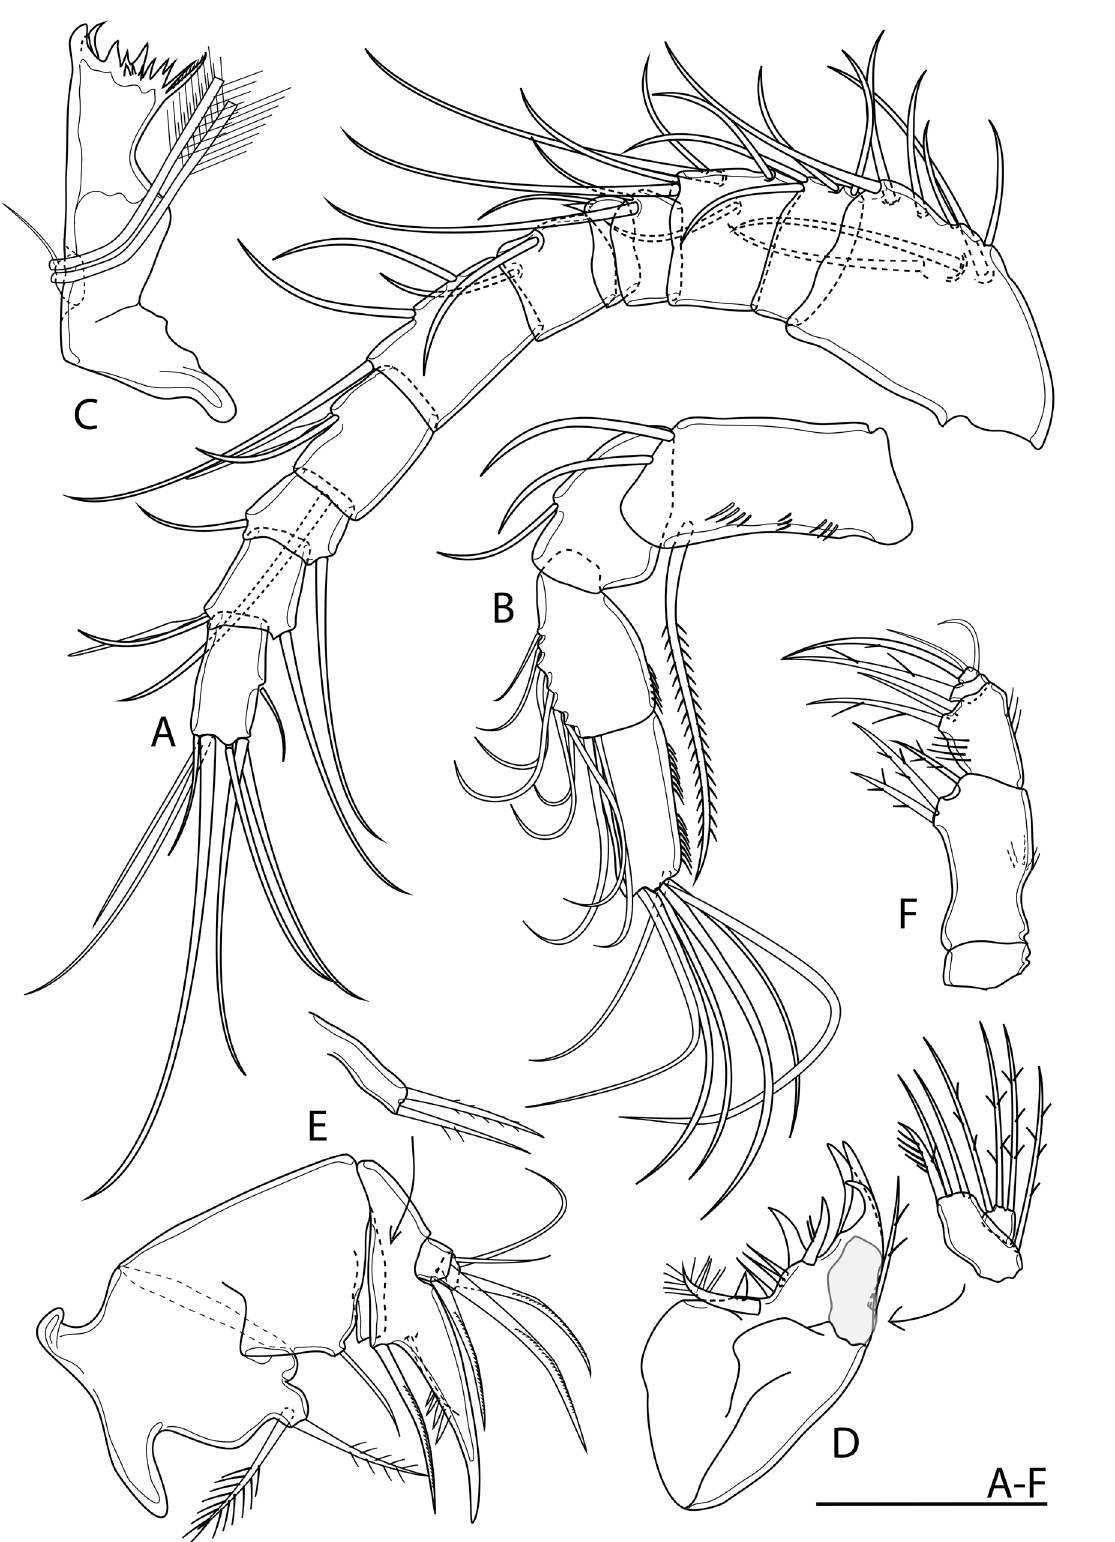
Fig. 12. Metacyclops brancelji sp. nov., holotype, ♀ (ZMB 34231 slide No. 5124). A . Antennule. B . Antenna, caudal view. C . Mandible. D . Maxillule, frontal view. E . Maxilla, frontal view. F . Maxilliped, frontal view. Scale bar = 50